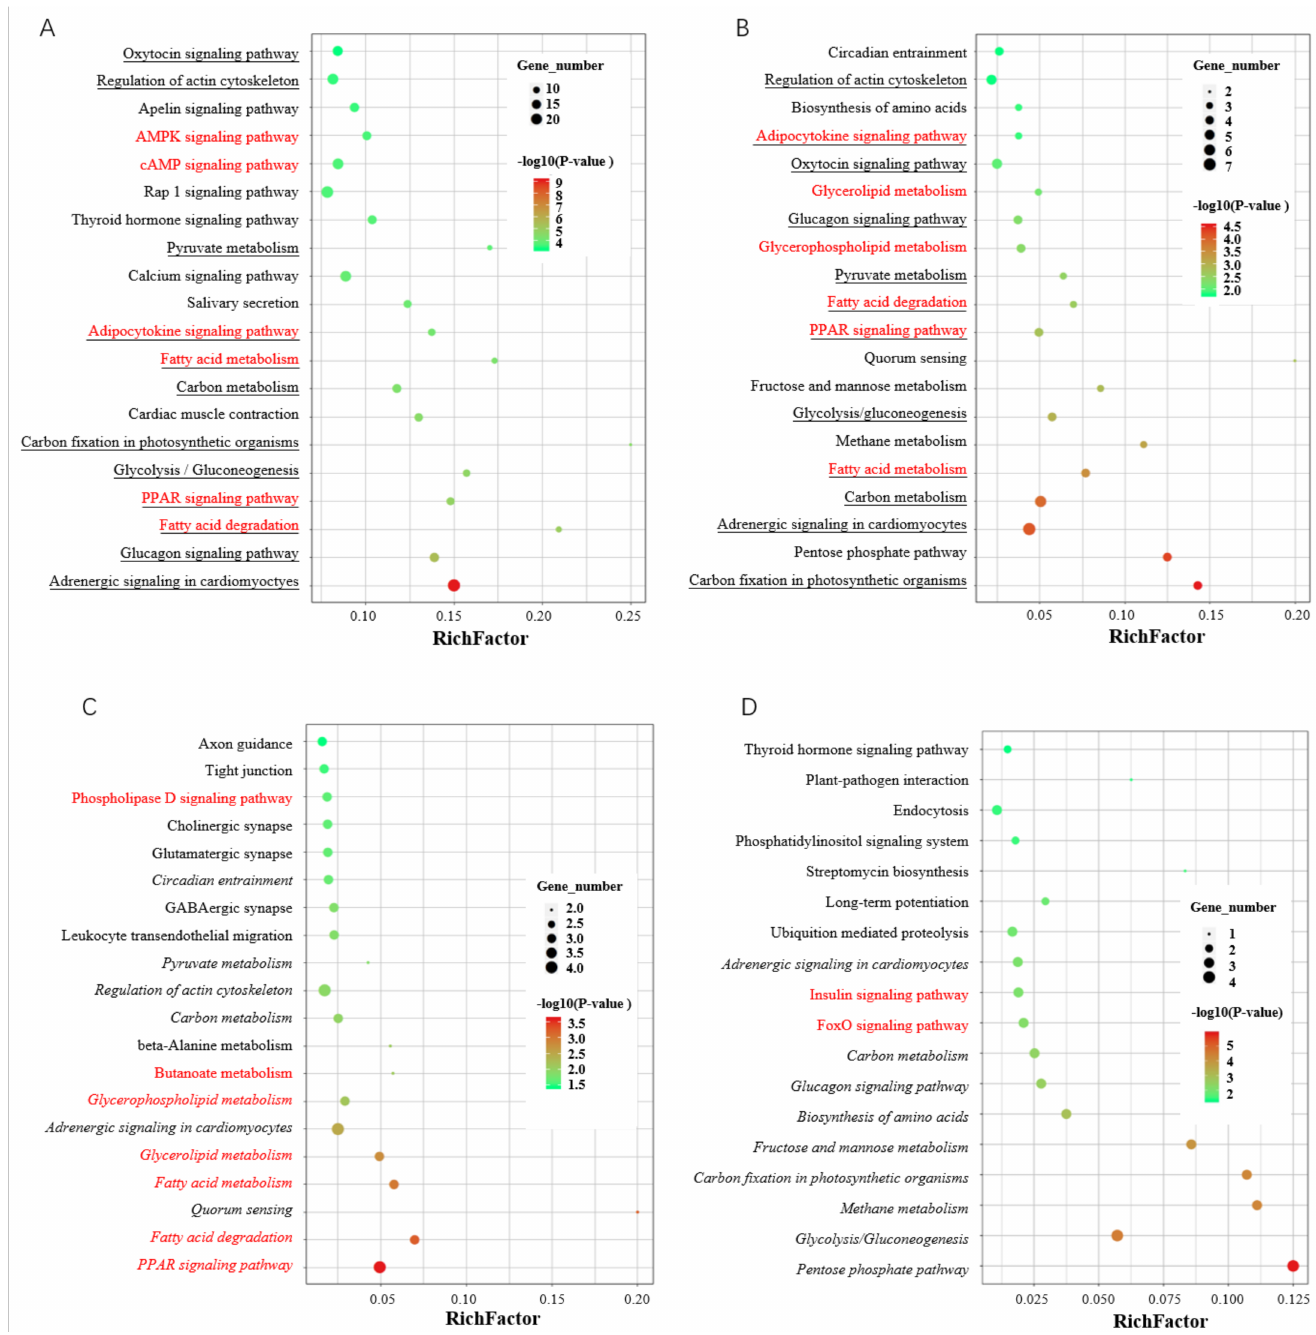
Figure 6. Functional characterization of differentially expressed (DE) differential alternative splicing (DAS) genes. ( A ) Top 20 KEGG pathways significantly enriched by DE genes (DEGs); ( B ) top 20 KEGG pathways significantly enriched by DE-DAS genes; ( C ) top 20 pathways significantly enriched by upregulated DE-DAS genes; ( D ) all pathways significantly enriched by downregulated DE-DAS genes. The pathways involved in fat formation are indicated in red, and those shared by the top 20 of DEGs and DE-DAS are underlined; all pathways overlapped between enrichments of all and upregulated or downregulated DE-DAS genes are indicated in